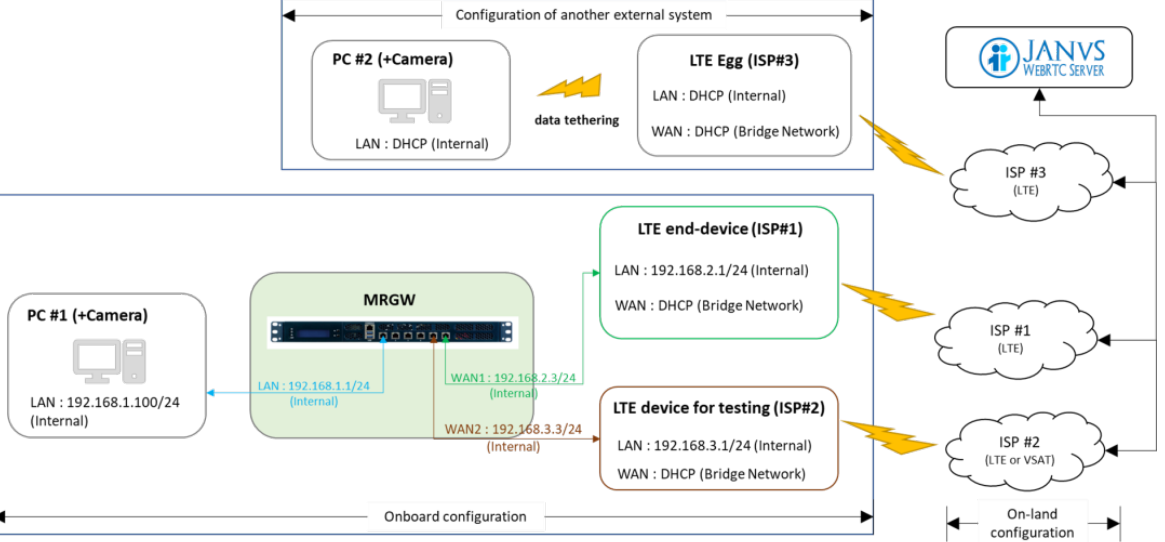
Figure 12. System configuration for test scenario 2 for evaluating the support for real-time video streaming data provided by the MRGW’s operation.